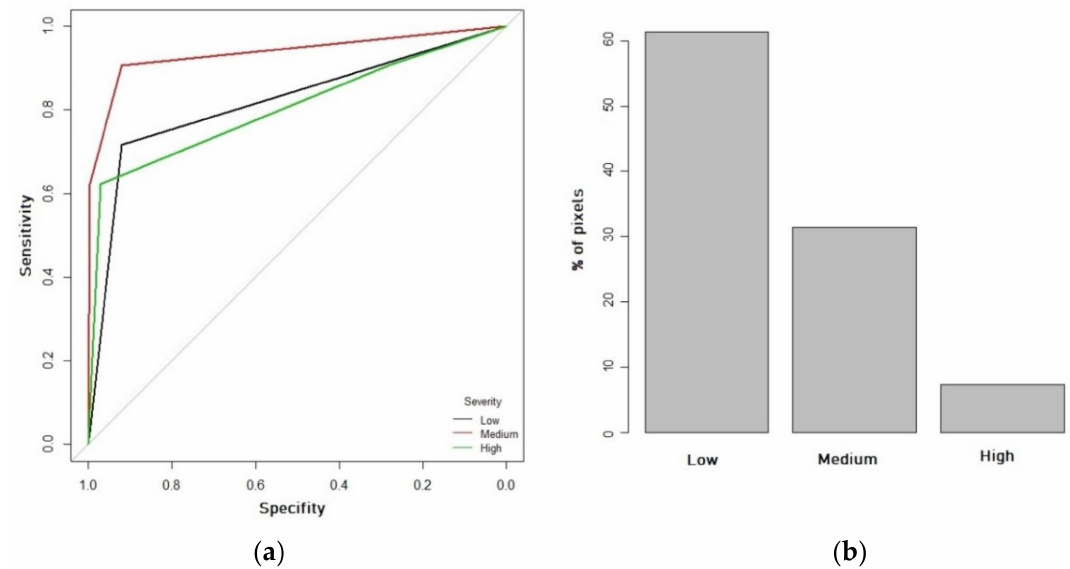
Figure 5. Area under the ROC curve for each severity class ( a ). Percentage of pixels classified into each severity class ( b ).